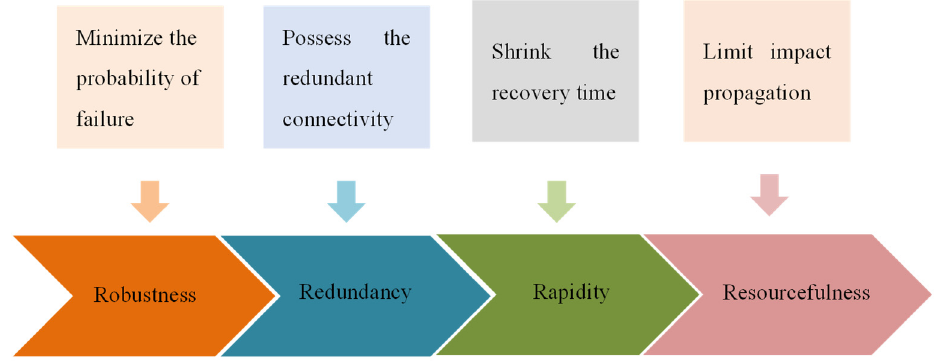
Figure 5. The relationship between resilient infrastructure and four properties of resilience.